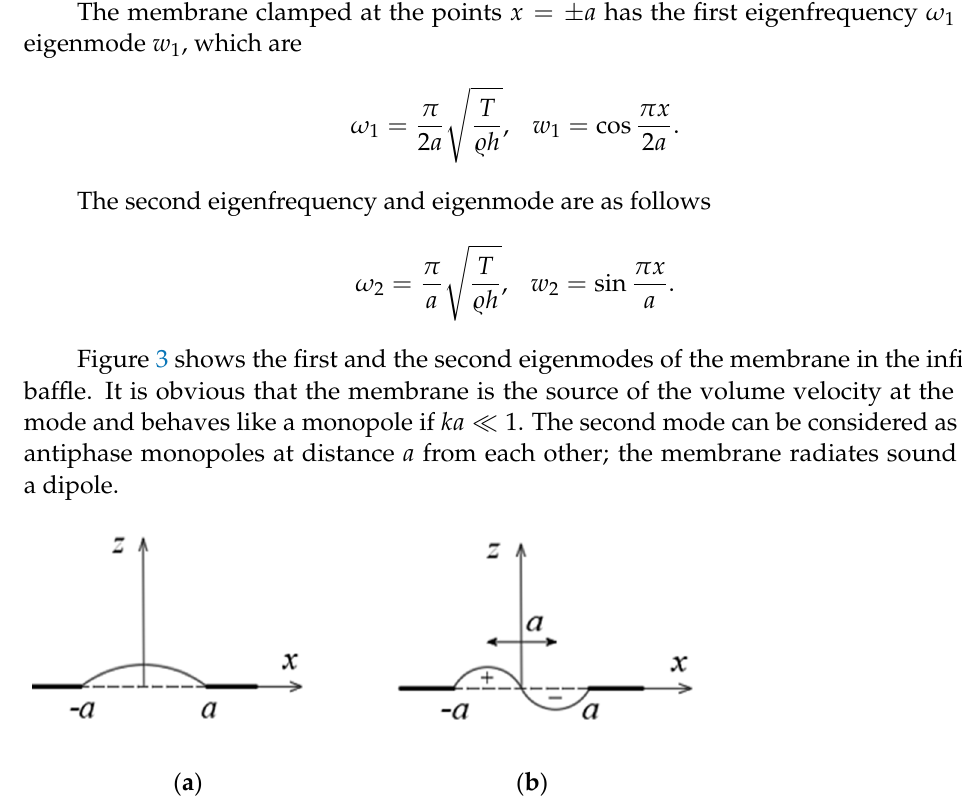
Figure 3. The first ( a ) and second ( b ) eigenmodes of the membrane in the infinite baffle.